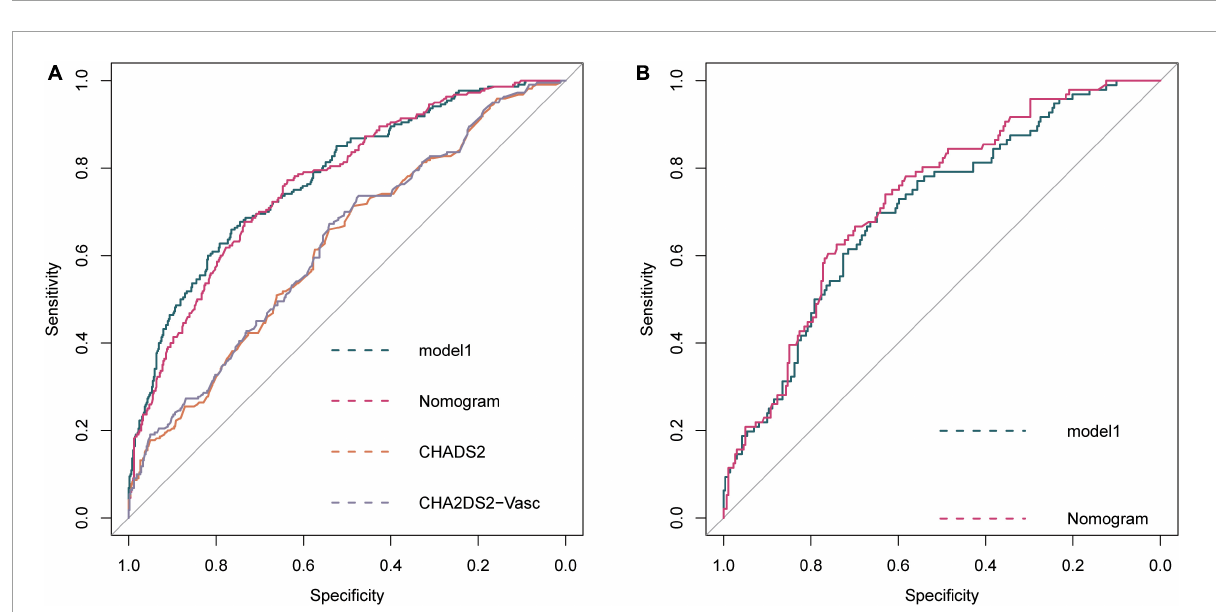
FIGURE2 Receiver operating characteristic (ROC) curve of prediction model. (A) Development cohort; (B) Validation cohort. Model 1: Recurrence ∼ age + snoring + BMI + AF history + hypertension + coronary heart disease + diabetes + heart failure + valve diseases + cardiomyopathy + persistent AF + LA. HASBLP: Recurrence ∼ age + snoring + BMI + AF history + persistent AF + LA. CHADS2: Recurrence ∼ heart failure + hypertension + age + diabetes + stroke. CHA2DS2-Vasc: Recurrence ∼ heart failure + hypertension + age + diabetes + stroke + vascular disease +